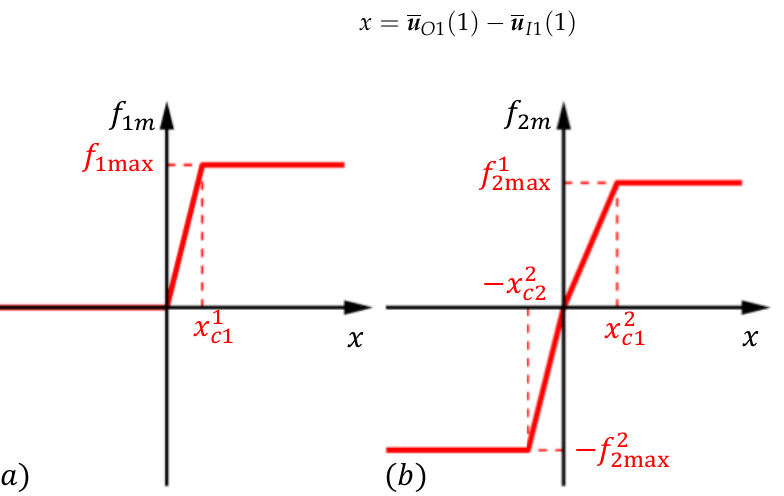
Figure 9. The buffer force magnitude f im with respect to buffer stroke x in ( a ) the main strut and ( b ) two secondary struts. The buffer force magnitude in two secondary struts has the same function, f 2 m = f 3 m , which is shown in Figure 9b. The x axis is the secondary strut buffer stroke computed by the relative translation distance between the u O 2 and u I 2 , which are also expressed in local coordinates. The parameter values in Figure 9 are listed in Table